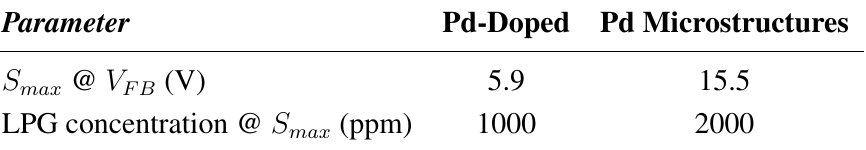
Table 3. Performance parameters for LPG